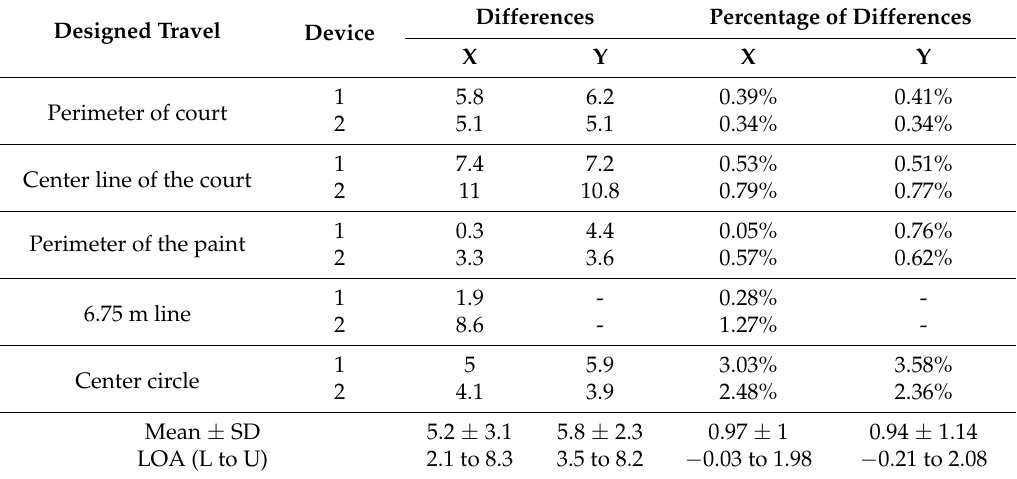
Table 1. Accuracy in mean differences (cm) and percentage of differences of x- and y-position coordinates. Designed Travel Device